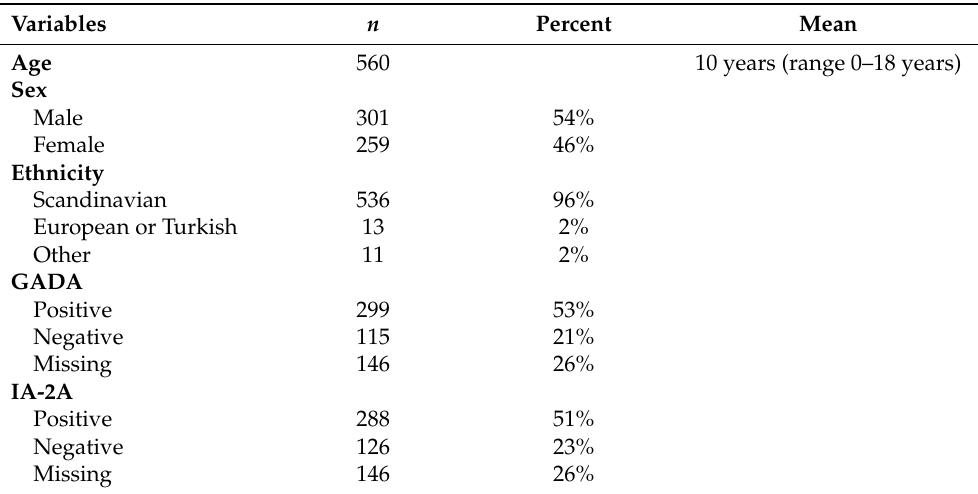
Table 1. Participant demographics. Abbreviations : IA-2A, tyrosine phosphatase autoantibodies; GADA, glutamic acid decarboxylase